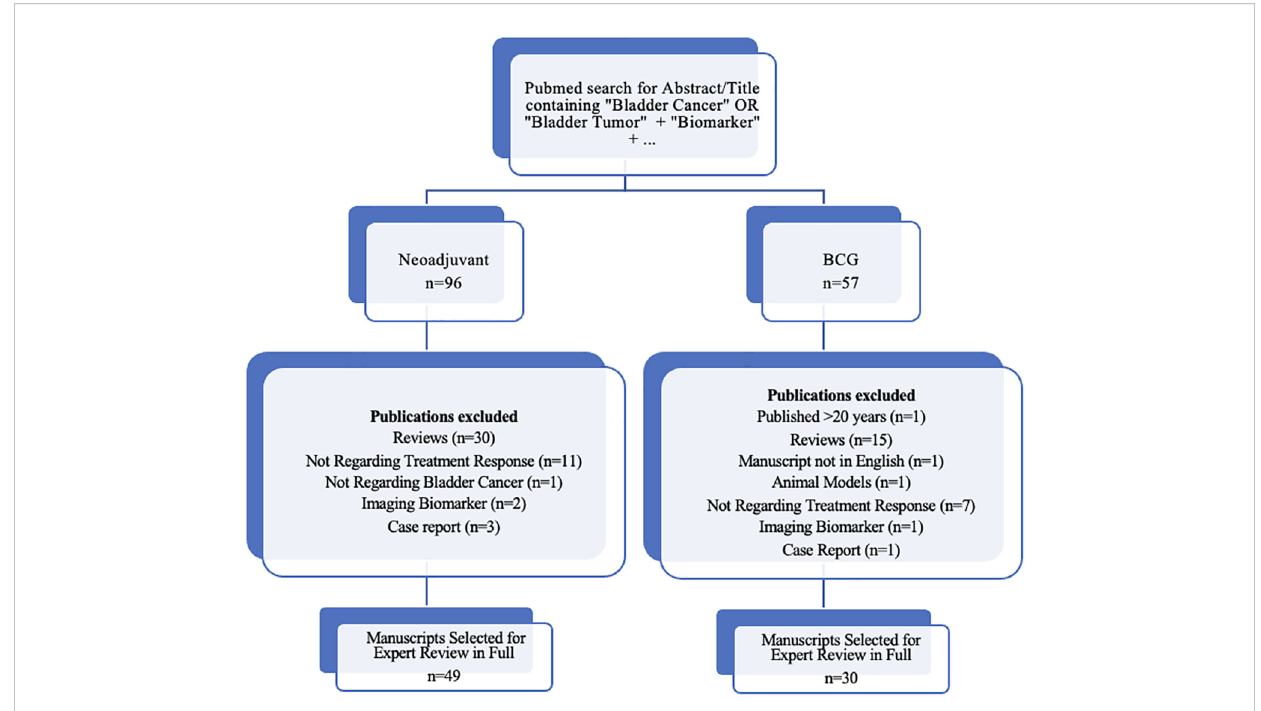
FIGURE 1 Diagram of search results and inclusion